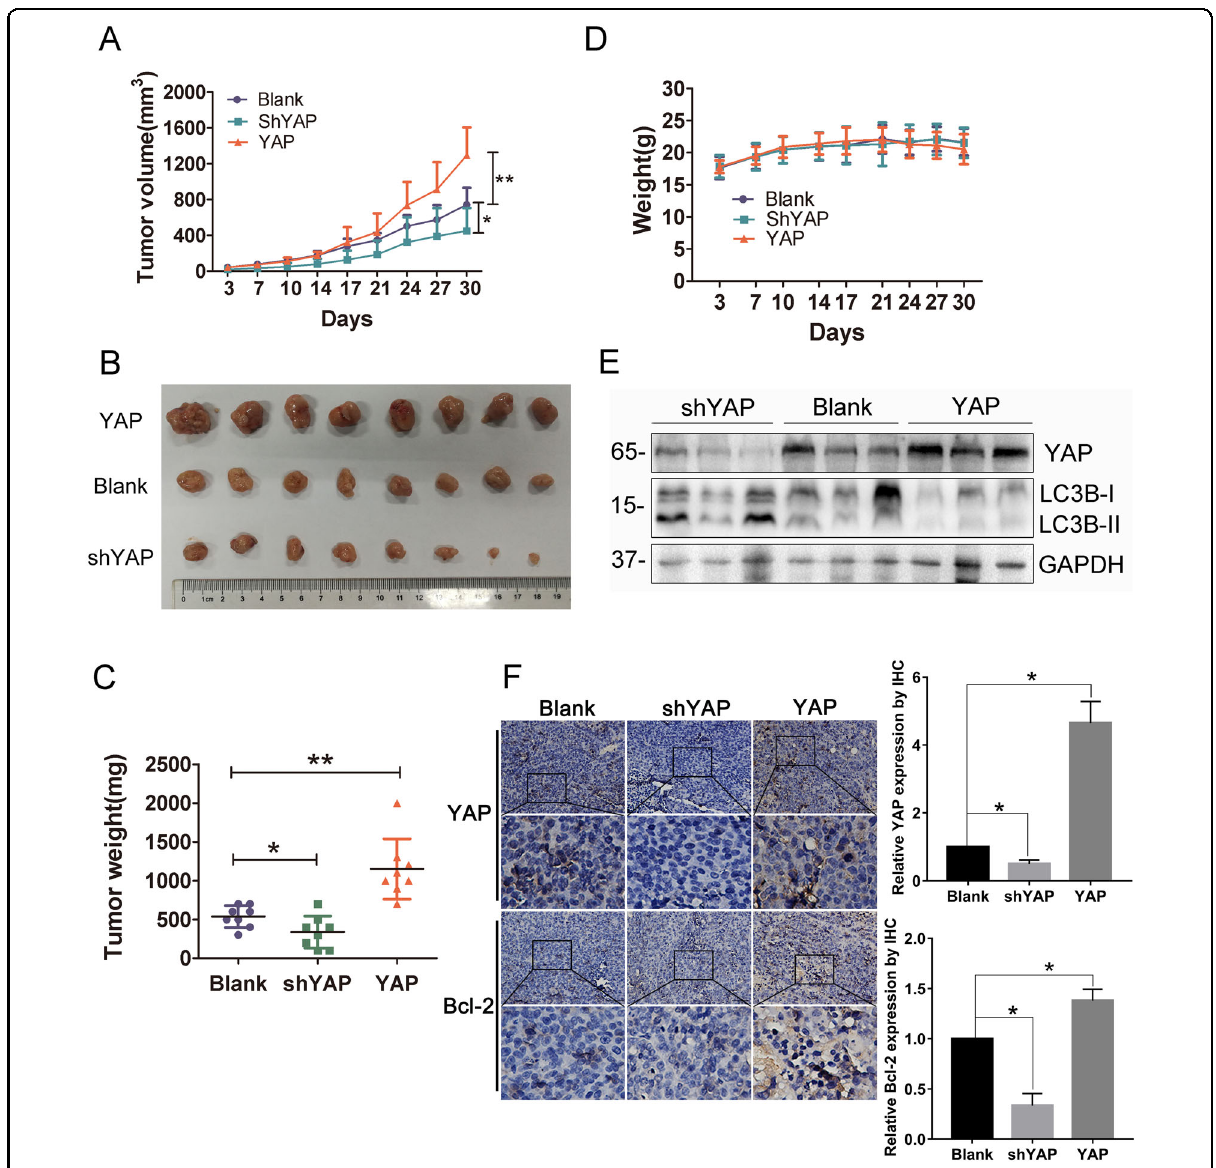
Fig. 4 YAP inhibits autophagy and promotes the growth of CRC cells in vivo. SW620 cells with stable YAP overexpression (YAP), knocking down of YAP (shYAP), or control cells (Blank) were subcutaneously injected into nude mice. A Tumor size and D body weight of the mice were measured twice a week. B Tumor tissues were collected from the sacri fi ced mice nearly 5 weeks after injection of the cells, and C weights of the formed tumors were measured for statistic analysis. E The expressions of YAP and LC3B in the tumor tissues were measured by western blot, using GAPDH as a loading control. F The expression of YAP and Bcl-2 in the tumor tissues was detected by IHC. Data represent mean ± SD. * P < 0.05, ** P <